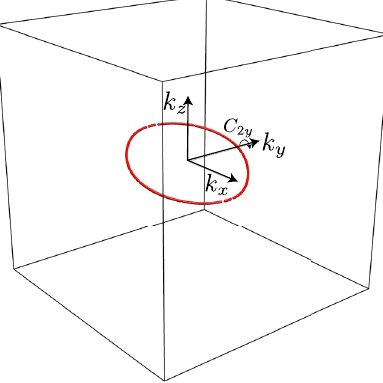
FIG. 13. The nodal line of the tight-binding model in Eq. (112) for μ ¼ þ 1 .